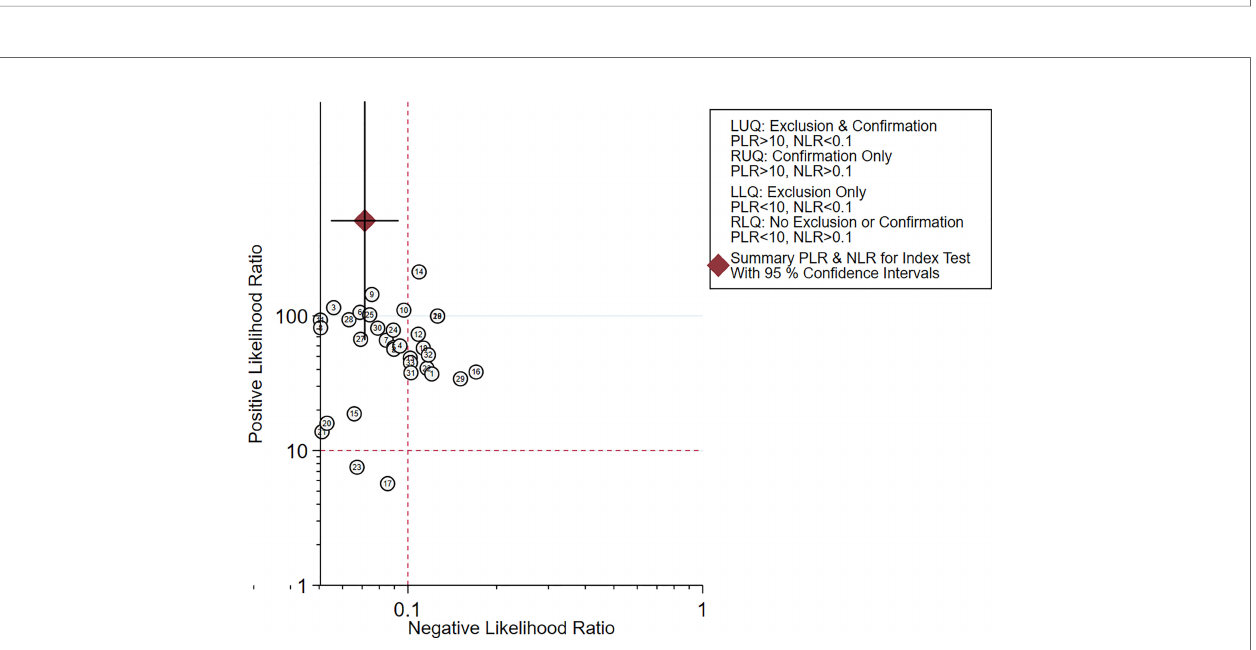
FIGURE 7 | Symmetric SROC curve of the diagnosis value of CNSs in SLNB of breast cancer. SROC, summary receiver operating characteristic curve; AUC, the area under the receiver-operator characteristic curve.